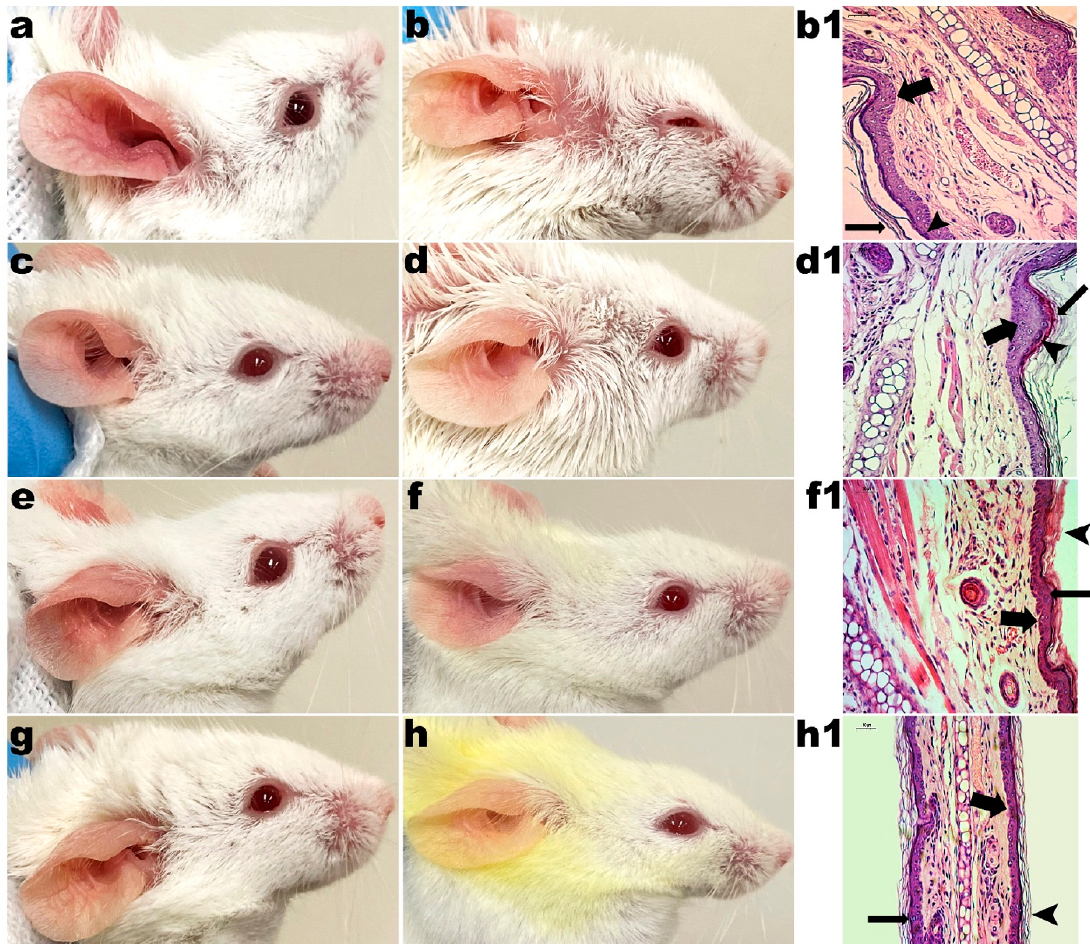
Figure 6. Results obtained after IMQ-induced psoriasis and application of the formulations in the ears of female mice. ( a ) (G5) 10 days of application of IMQ; (b ) (G5) natural recovery of the